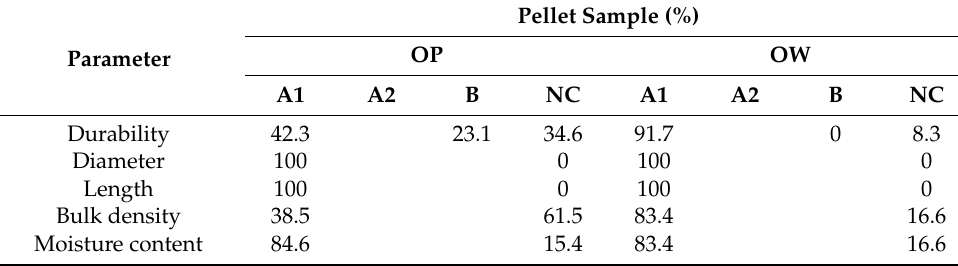
Table 4. Percentage of pellet samples that satisfy the criteria present in EN 14961-2 for pellet